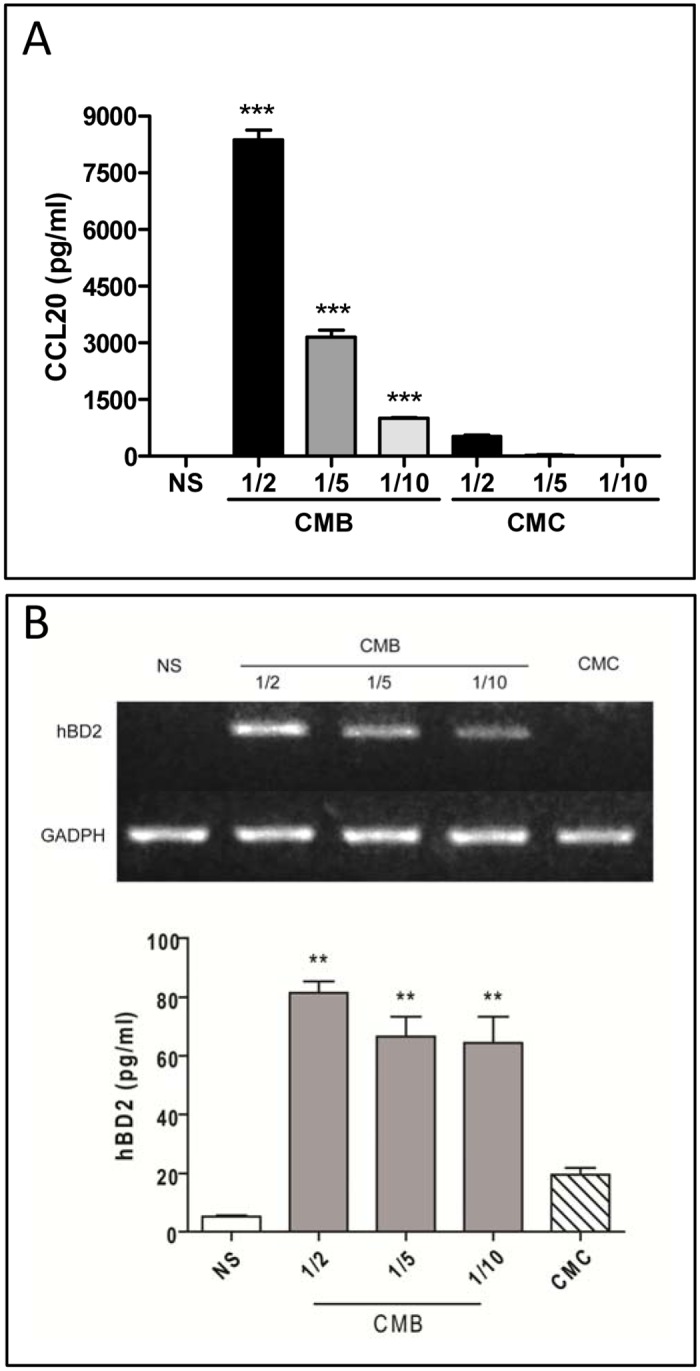
Factors secreted by B. abortus-infected monocytes enhance the secretion of CCL20 and hBD2 by alveolar epithelial cells.(A) Cells were exposed to different dilutions of conditioned medium from B. abortus-infected THP-1 monocytes (CMB) or from uninfected monocytes (CMC), and 24 h later the levels of CCL20 were measured in culture supernatants. (B) Cells were treated as above and 24 h later transcription levels of mRNA for hBD2 were determined by semiquantitative RT-PCR (upper panel), and culture supernatants were harvested for measuring hBD2 levels by commercial ELISA (lower panel). ELISA data are mean ± SEM of CCL20 or hBD2 levels measured in three independent experiments in stimulated cultures after subtracting preexisting levels in the transferred CMB or CMC. **, p<0.01, ***, p<0.001, and ns, non-significant difference versus non-stimulated (NS) cells (ANOVA followed by Dunnett’s test).